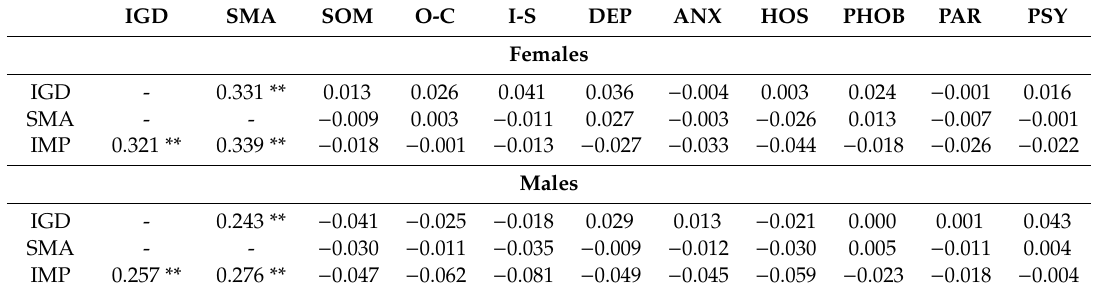
Table 3. Bivariate correlations between the variables of interest for each gender group.